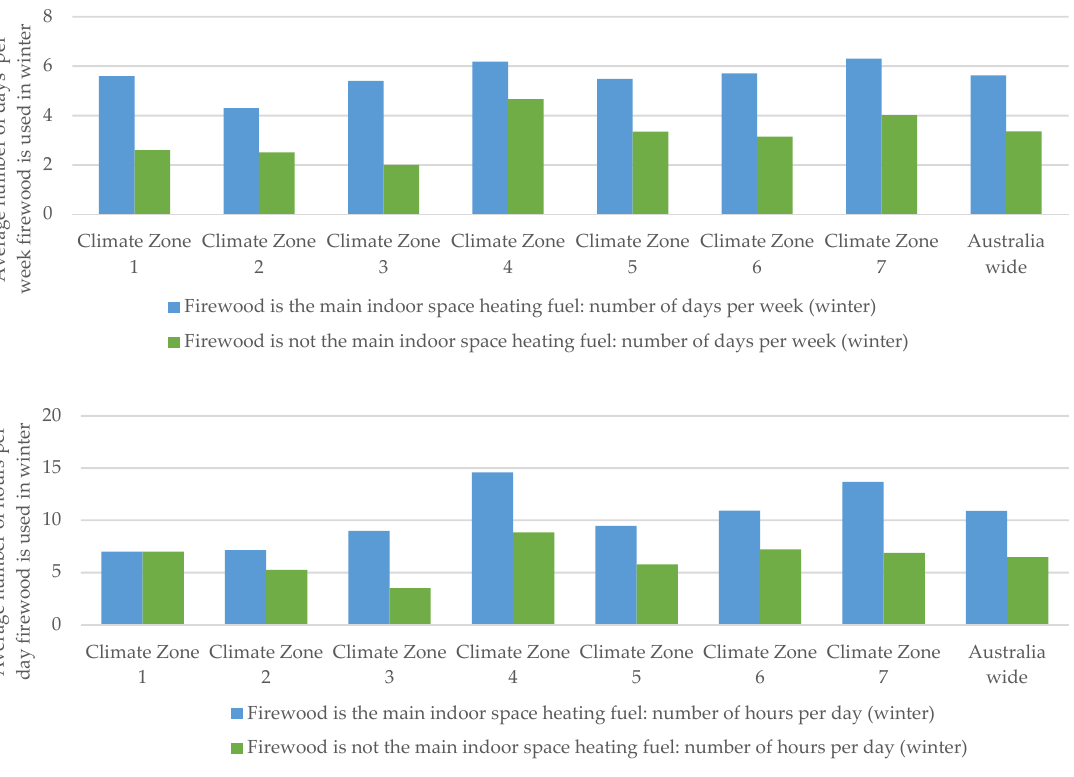
Figure 5. Frequency and duration of firewood use for indoor space heating for each climate zone (n~935).